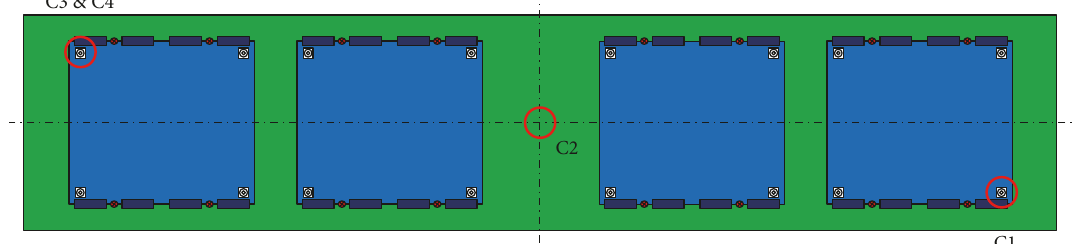
Figure 22: Check points of the acceleration of maglev